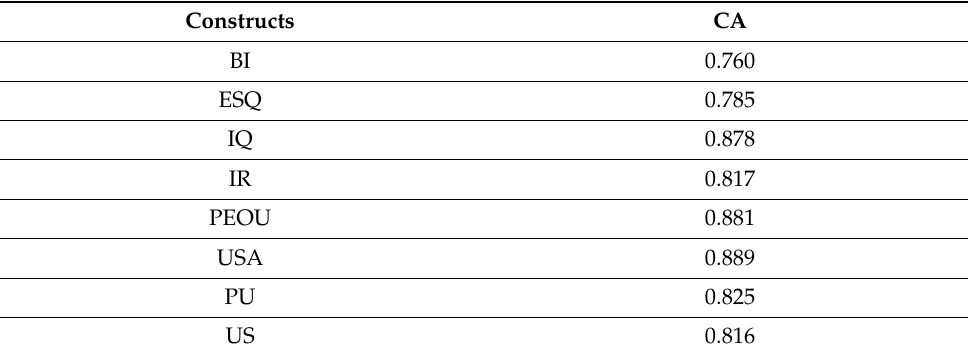
Table 3. Cronbach’s alpha values for the pilot study (CA ≥